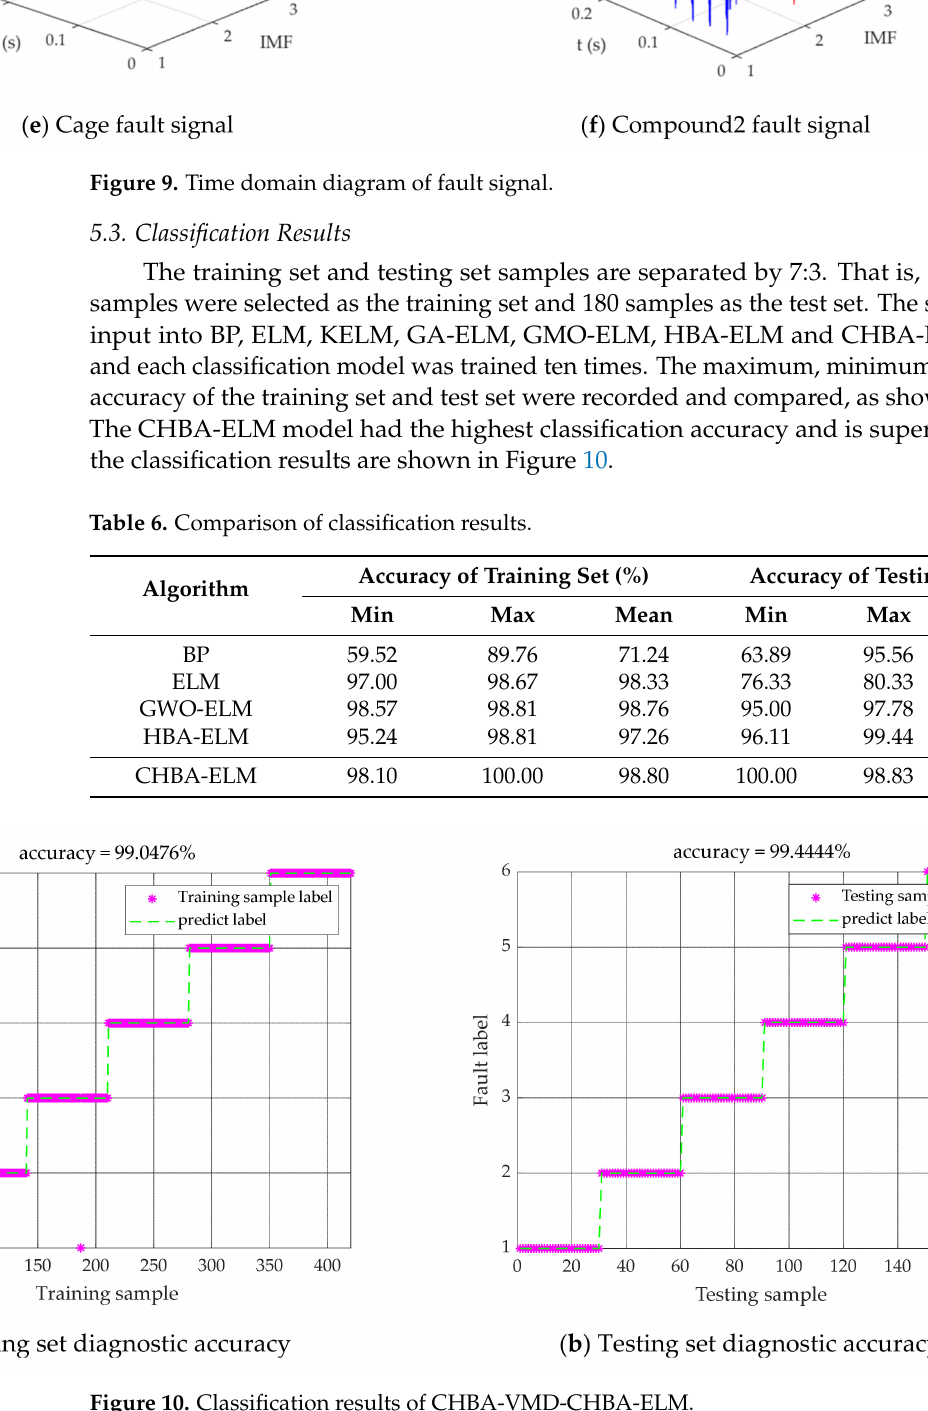
Figure 10. Classification results of